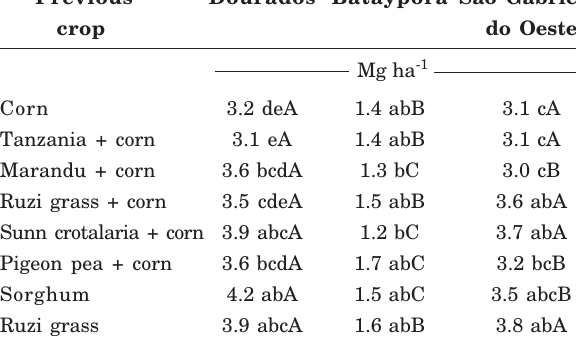
Means followed by the same lowercase letter in a column, and by the same uppercase letter in a row are not significantly different by the Tukey test (p 0.05).